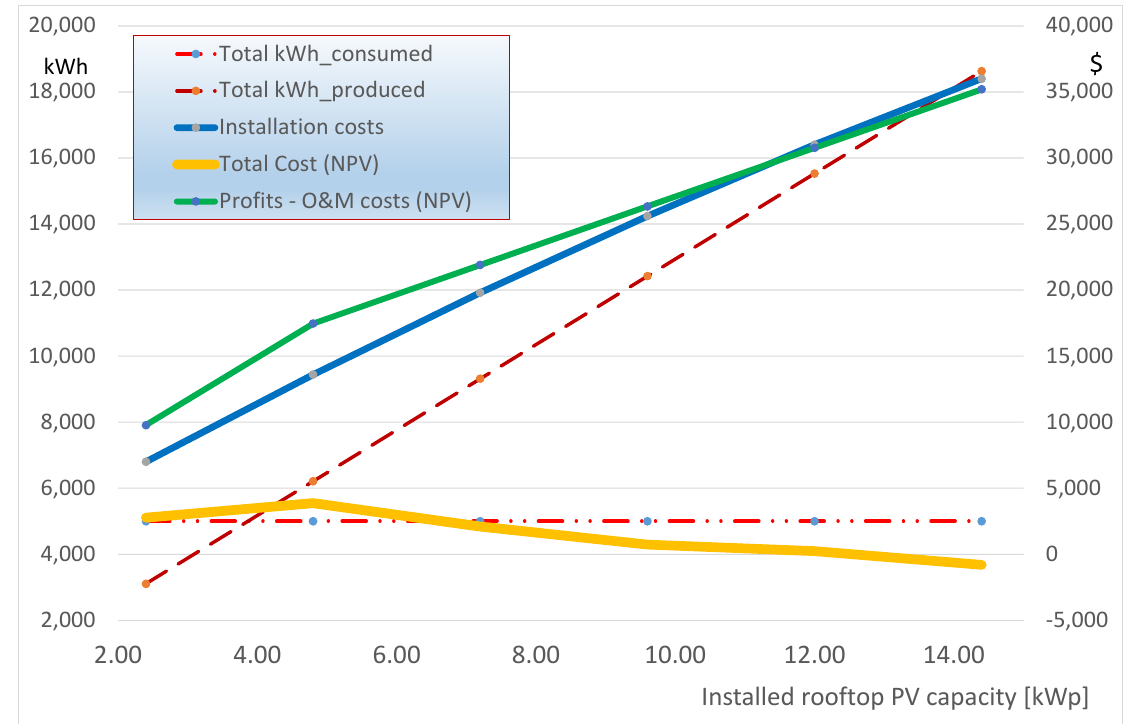
Figure 14. Lifetime performance (20 years) of the system with variable capacity of rooftop PV installation. Based on variable electricity pricing which pays an additional premium for electricity sent to the grid during the daily hours of peak consumption (8:00–14:00).